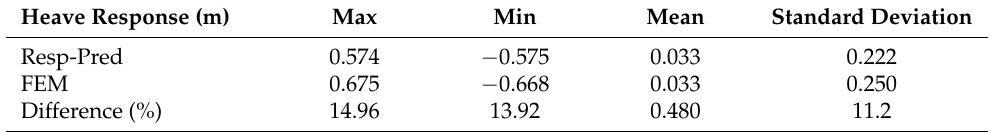
Table 4. Statistical heave responses of ANN and FEM at a wave height of 9.65 m and a period of 9.94 s. Heave Response